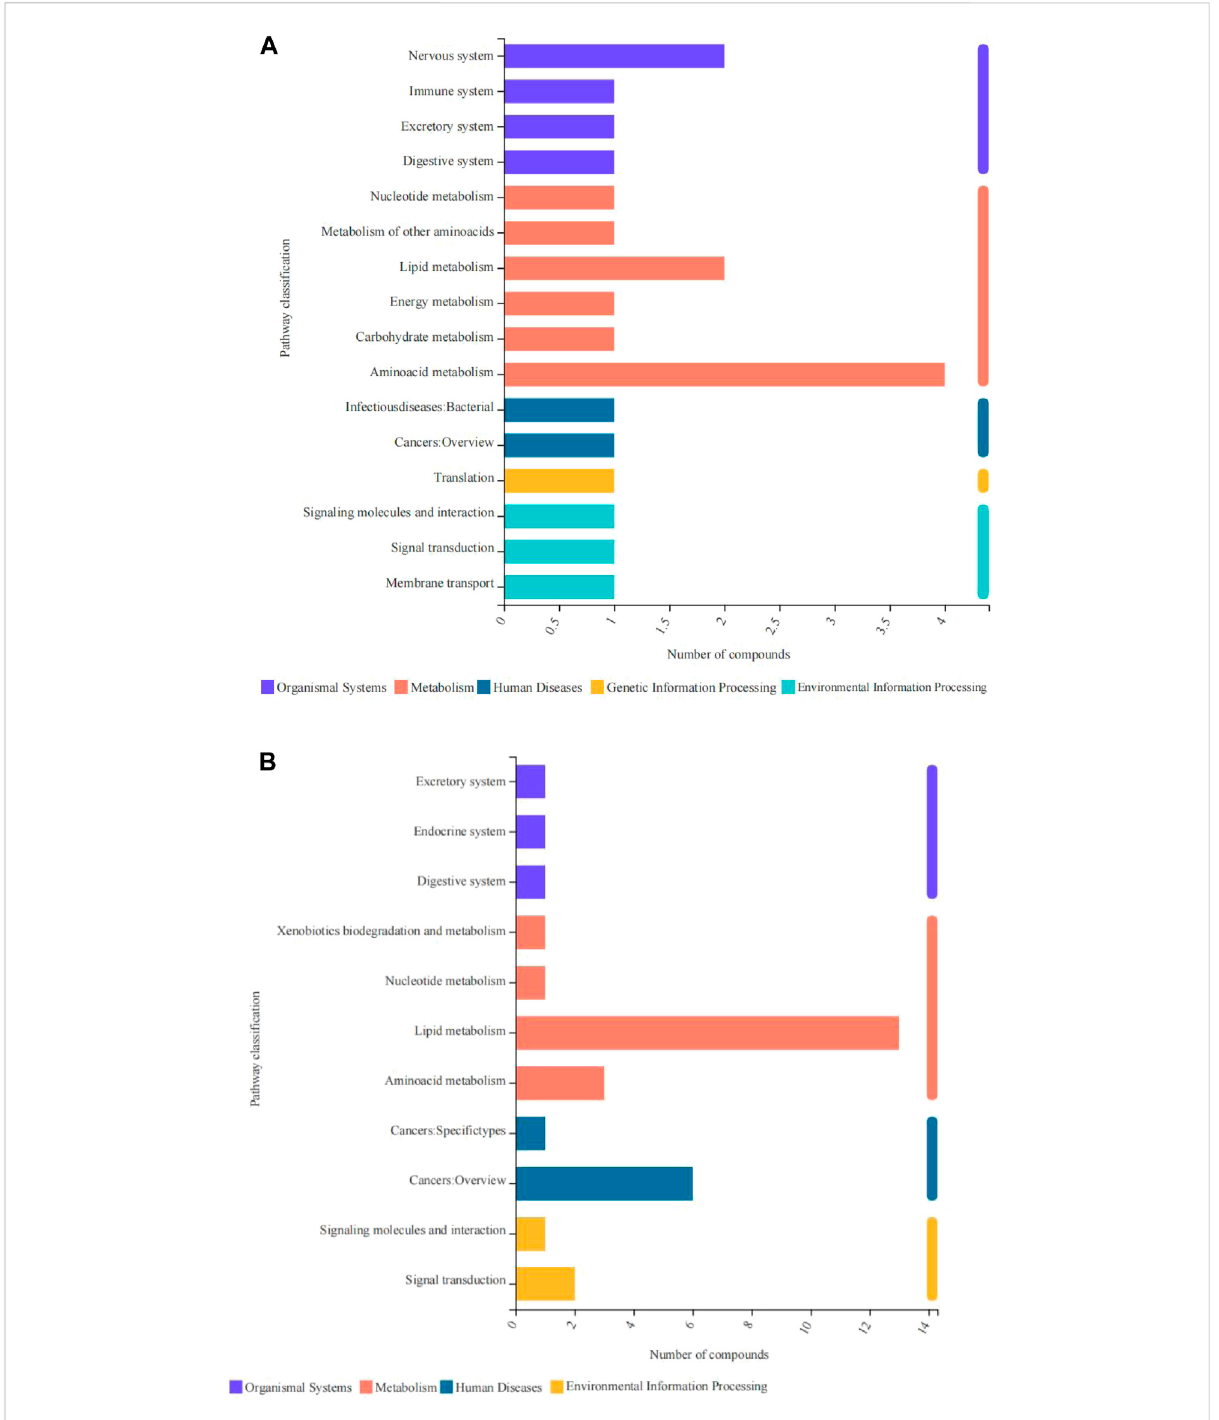
FIGURE 7 Pathway classi fi cation of differentially expressed metabolites derived from the fi sh subjected to cold stress. (A) upregulated metabolites. (B) downregulated